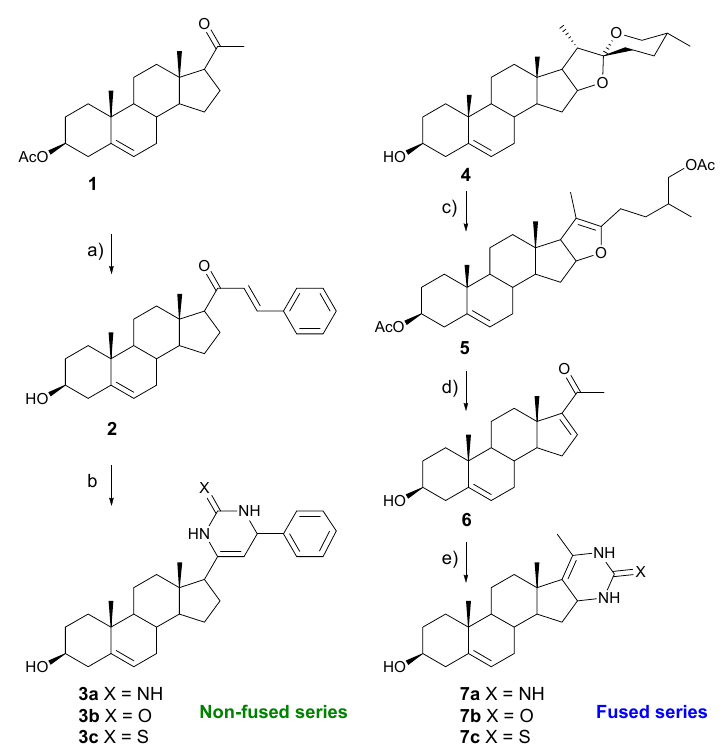
Table 1. Outcome of the cycloaddition reaction of ketones 2 and 6